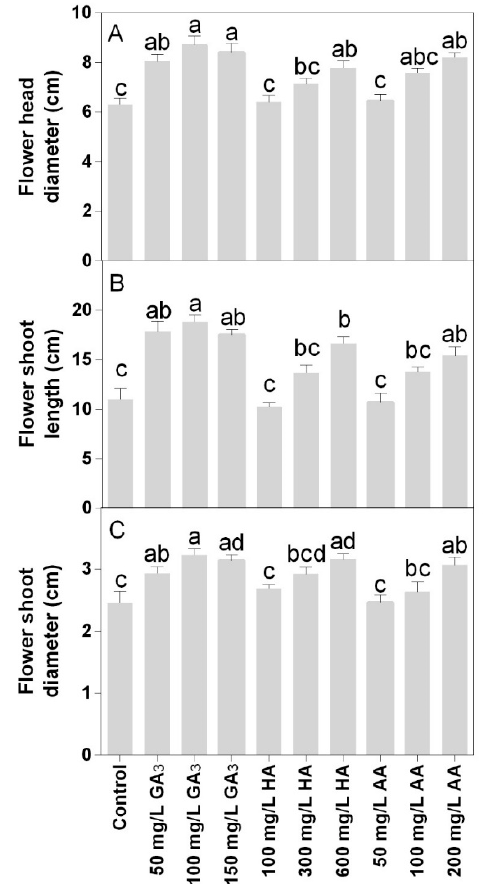
Figure 6. Effect of gibberellic acid (50–100–150 mg L − 1 GA), humic acid (100–300–600 mg L − 1 HA), and ascorbic acid (50–100–200 mg L − 1 AA) foliar applications on the Gazania ( A ) flower head diameter, ( B ) flower shoot length and ( C ) flower shoot diameter. Values are means ± SD ( n = 15). Data were